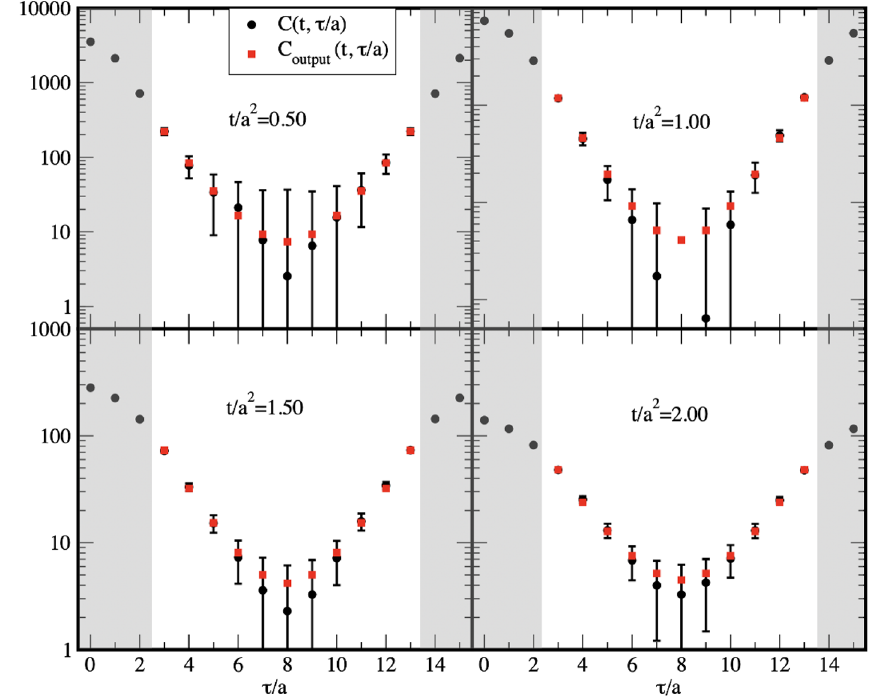
Figure 7 . Comparison between the input C ( t; (cid:28)=a ) with the jackknife error and the output C output ( t; (cid:28)=a ) constructed by the obtained ~ (cid:26) ( t; a! ). The input C ( t; (cid:28)=a ) in shadowing regime are not utilized in the